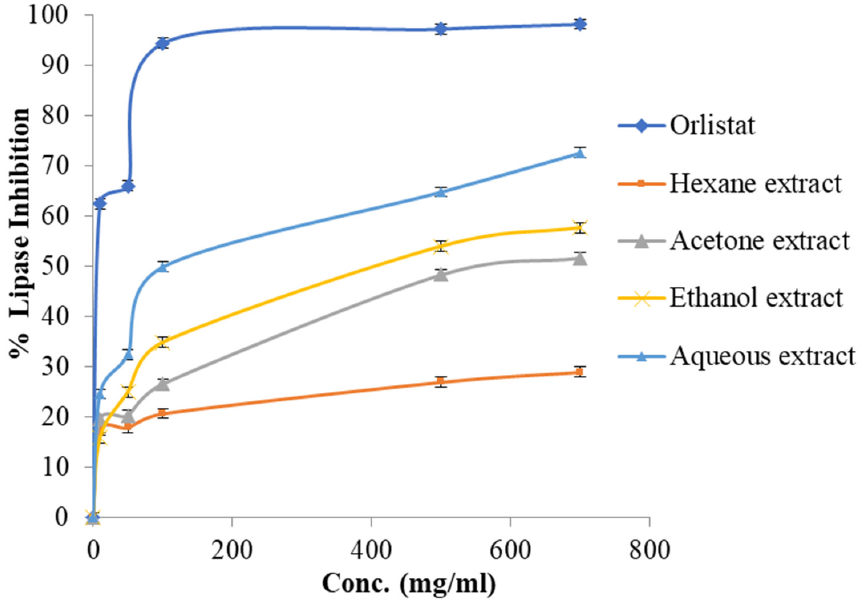
Figure 2. Pancreatic lipase inhibitory effect by Artemisia scoparia four extracts and Orlistat. Values are the mean ± SD of triplicate experiments ( p -value < 0.05).